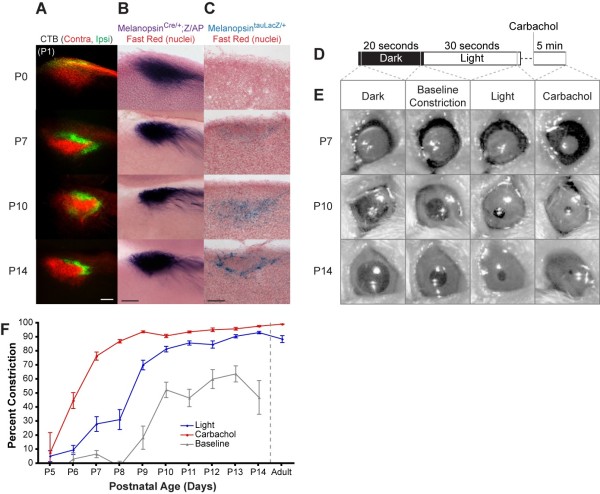
Olivary pretectal nucleus innervation and onset of pupillary light responses. (A) The olivary pretectal nucleus (OPN) is innervated by CTB-labeled RGC axons at P0 and ipsilateral and contralateral axons have segregated by P7. (B) MelanopsinCre/+;Z/AP-labeled axons show a similar innervation pattern from birth. (C) In contrast, MelanopsintauLacZ/+-labeled axons are not detected until P7 and show adult-like innervation of the OPN shell by P14. (D,E) The paradigm used for all pupil measurements (D) and representative images (E). Note that the pupil appears white at P7 because at this early time point it was necessary to reflect infrared light off the back of the eye to make the iris visible to the camera. Carbachol was used to induce maximal constriction of the ciliary muscle. (F) Percent constriction of pupil was measured and the summary of data for PLR is shown. Significant light responses are detected from P7 onward (n = 3 or more mice per time point, one-way ANOVA with Tukey post hoc test, error bars are mean ± standard error of the mean). No baseline constriction was observed in adult mice. Scale bars: 100 μm (A-C).